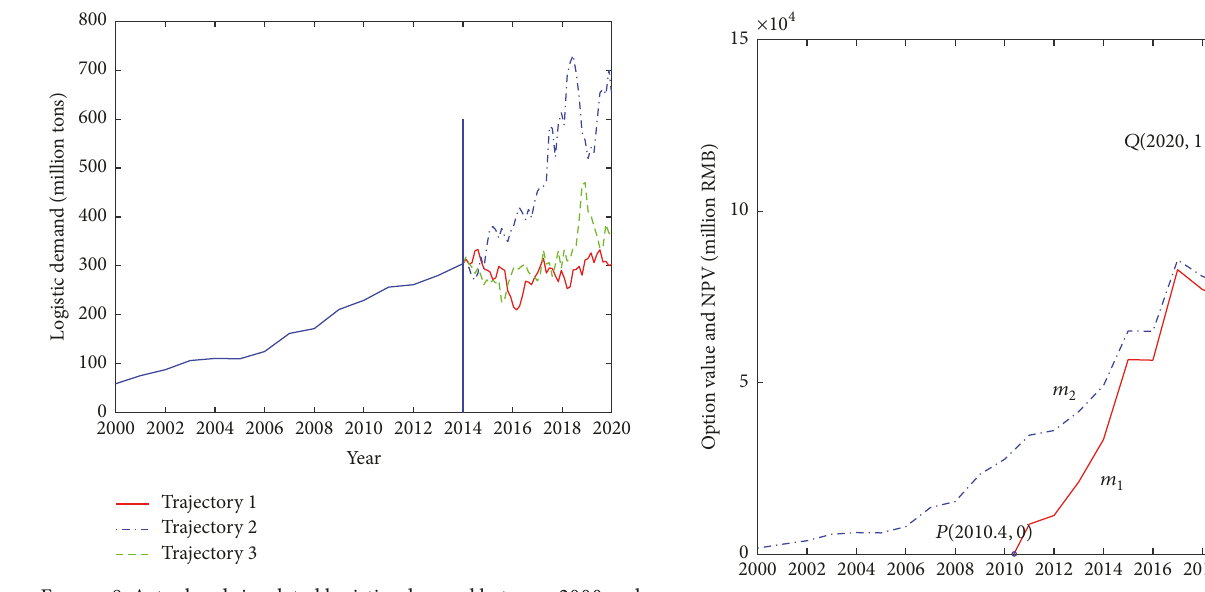
Figure 8: Actual and simulated logistics demand between 2000 and 2020.